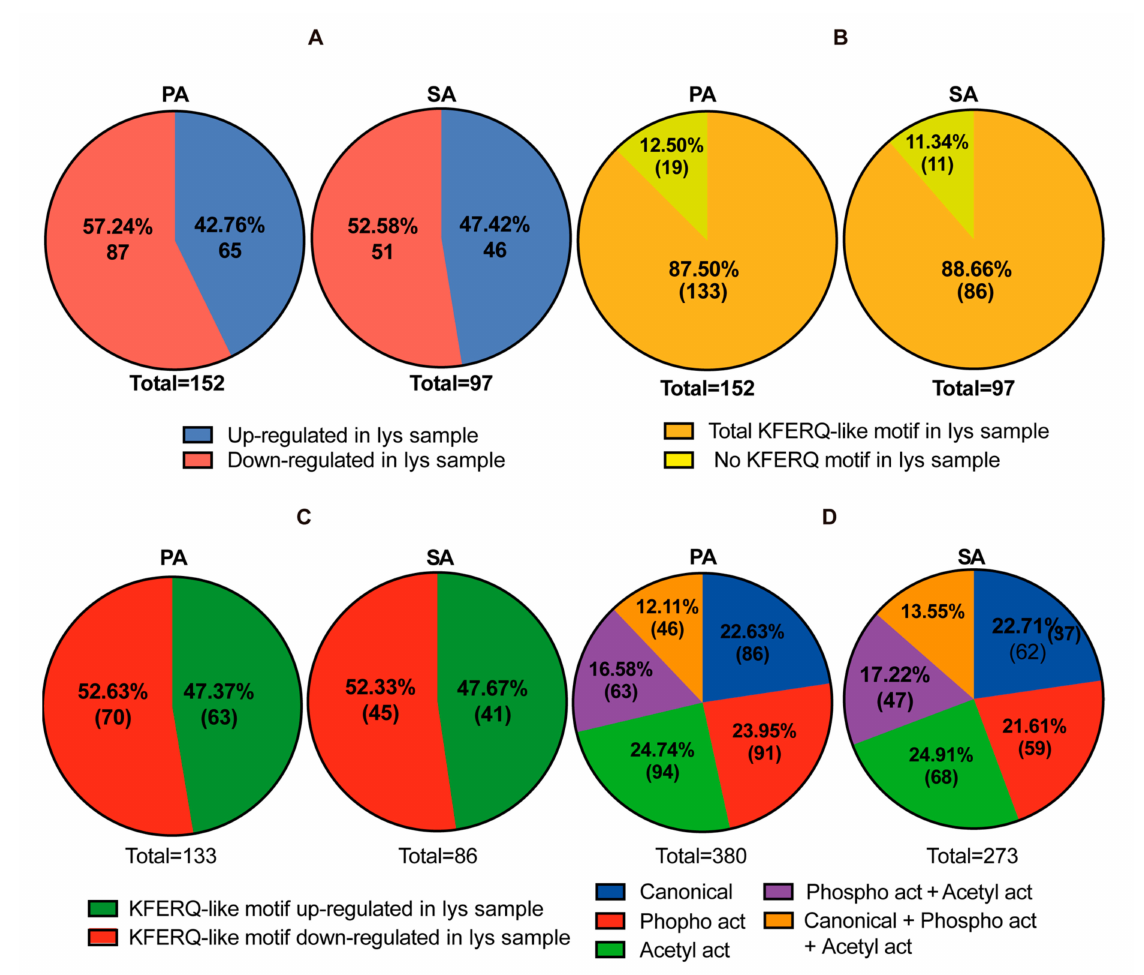
Figure 5. Analysis of putative CMA protein substrates in lysosomes from POMC-like neurons treated with PA and SA. POMC-like neurons (N43/5) were incubated with heavy DMEM/FBS mixture (SILAC Lys6 Arg6) and then incubated with 100 mM of PA, SA, or vehicle (BSA) for 6 h. Lysosomal fractionations were isolated from each condition as described in Figure 2 and their proteomic composition was analyzed by SILAC-based proteomics. The data were filtered using the following parameters: (i) proteins identified with high false discovery rates (FDRs) and with more than one peptide, (ii) proteins with a p -value of 0.05 (or less), and (iii) proteins with a fold change of 2. ( A ) Pie chart showing the number and percentage of up- and downregulated proteins. ( B ) Number and percentage of proteins from Figure 5A containing KFERQ-like motifs as analyzed using https://rshine.einsteinmed.org (accessed on 9 February 2022). ( C ) The number and percentage of proteins containing KFERQ-like motifs that are up- and downregulated in PA and SA. ( D ) The number and percentage of proteins containing different KFERQ-like